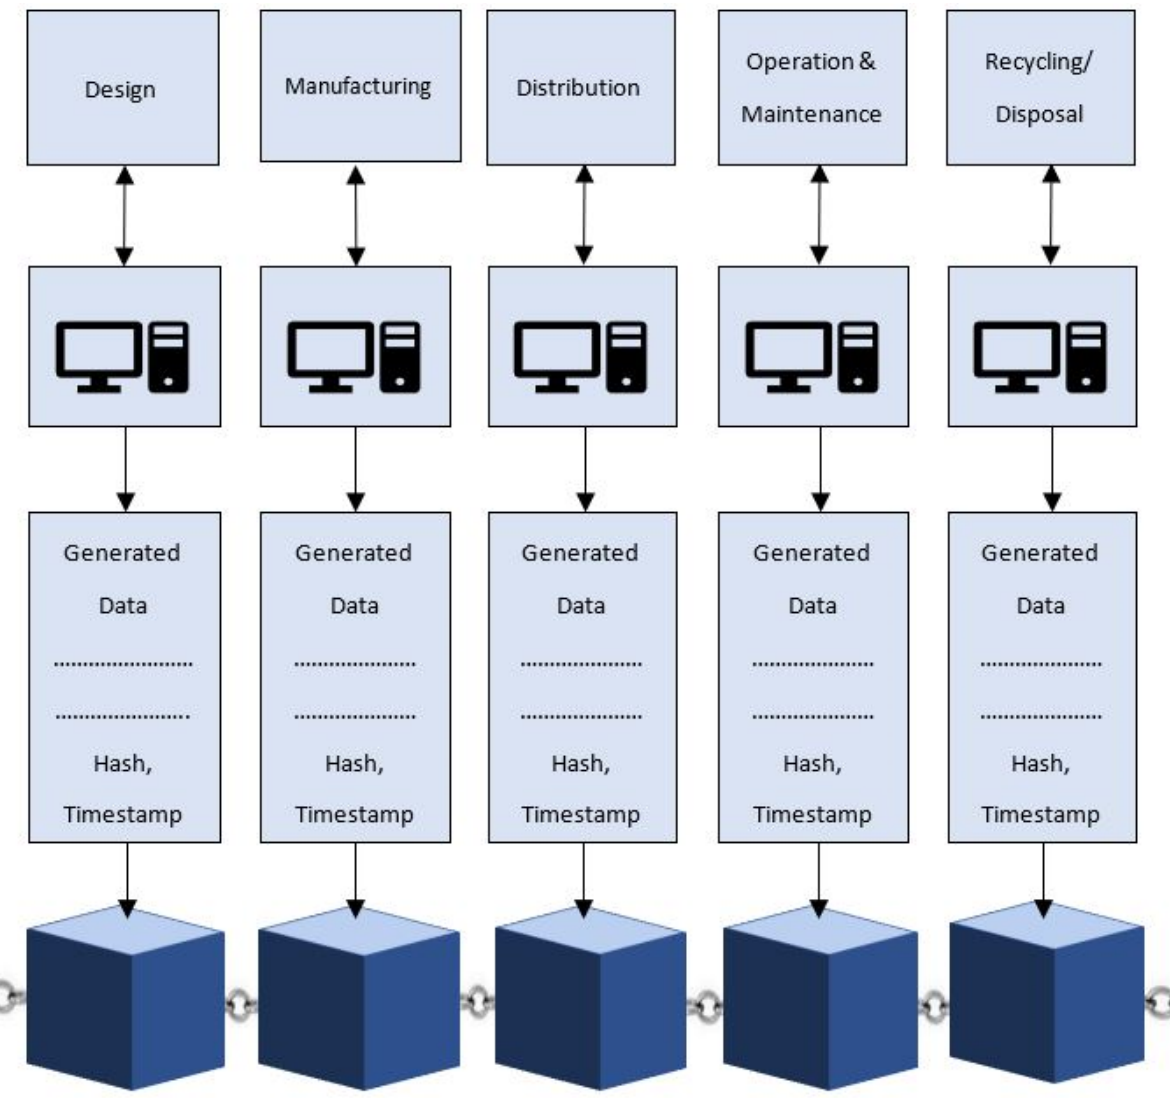
Figure 2. Conceptual Framework for a Blockchain-Based Platform.